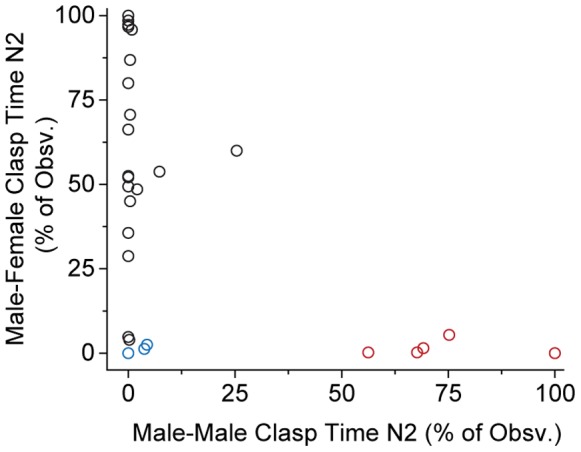
Most male X. laevis showed a preference for clasping female conspecifics, but some showed an apparent preference for males and some made little effort to clasp.Examination of the total time spent clasping the male and female conspecifics (measured as % of observations) showed that a subset of males spent considerable time clasping the conspecific male, even in the presence of a female. Red symbols indicate animals that showed a preference for clasping the conspecific male (chi-square tests, p<0.0001); black symbols indicate a preference for clasping the female (chi-square tests, p<0.0001); blue symbols indicate animals that showed no significant preference (p>α).